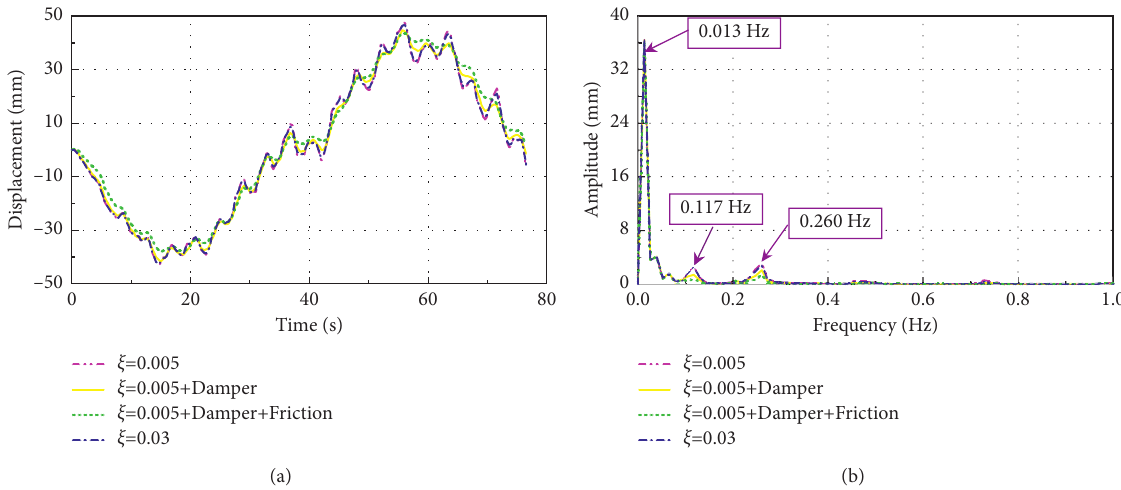
Figure 17: Girder end longitudinal displacement of the suspension bridge under a series of moving loads at 25m/s: (a) time history of longitudinal displacement; (b) Fourier spectrum of longitudinal displacement.